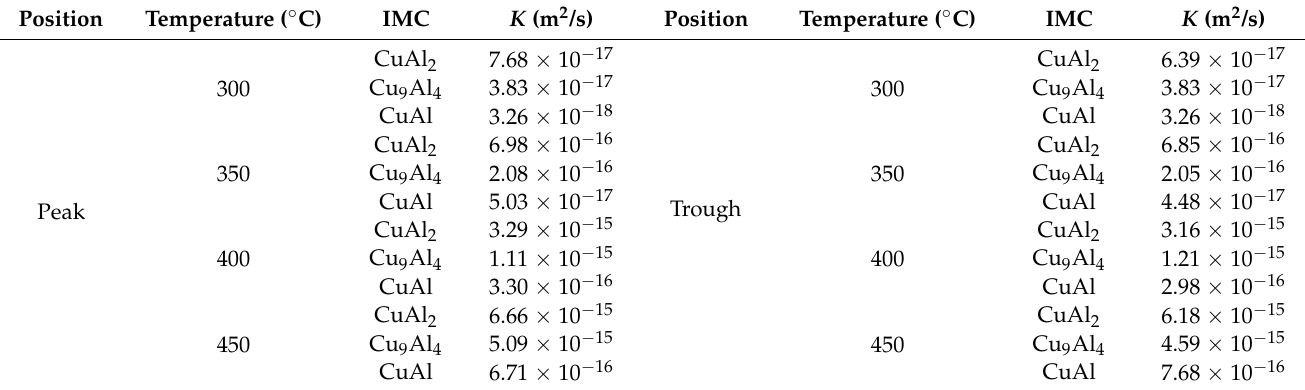
Table 4. Calculated growth rate